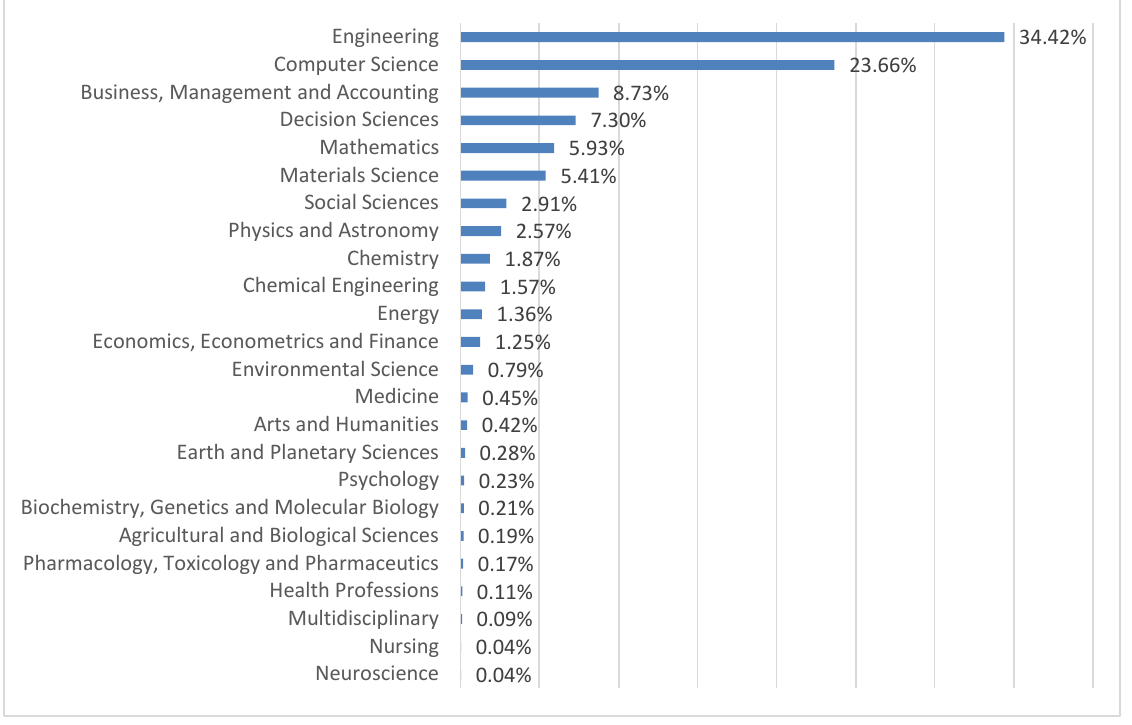
Figure 2. Publications per subject area